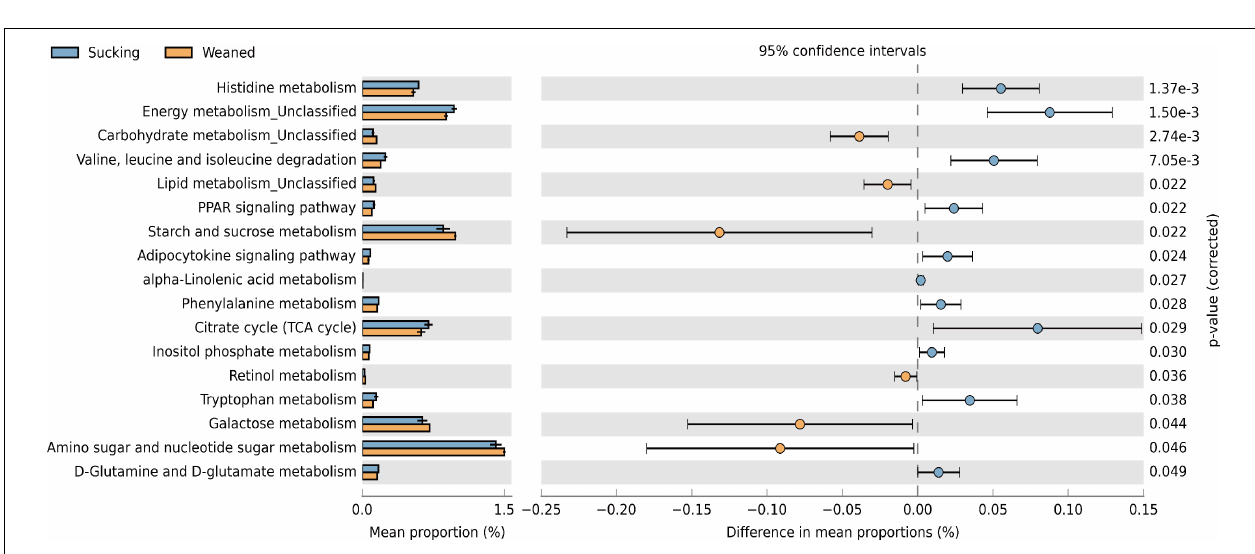
FIGURE 9 | Different microbes at the genus level between sucking piglets and weaned piglets. (A) Hierarchical clustering heat maps of different genera between sucking piglets and weaned piglets; S, sucking piglets; W, weaned piglets. (B) Statistical analysis of different genera between sucking piglets and weaned piglets. All values are expressed as the means ± SEMs ( n = 5–6). * P < 0.05.